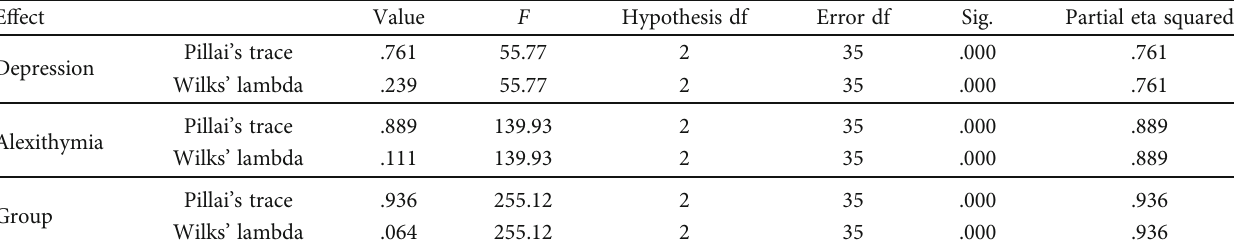
Table 4: Multivariate tests.